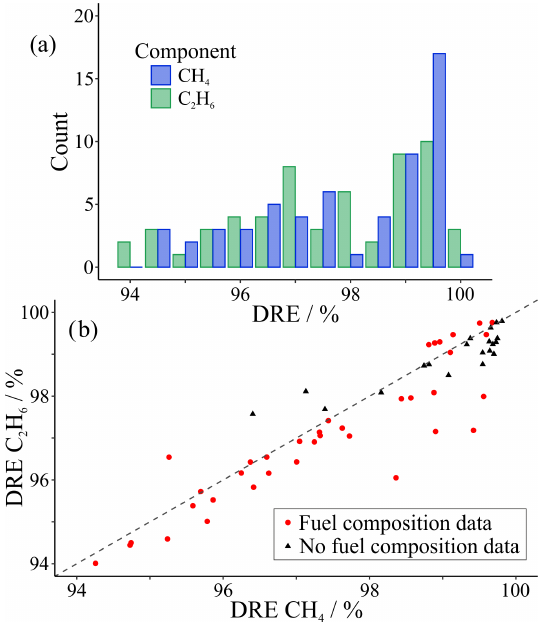
Figure 7. Histogram distribution of NO x emission ratios (ppmppm − 1 ) (a) calculated using CO 2 as the reference gas and (b) calculated using CH 4 as the reference